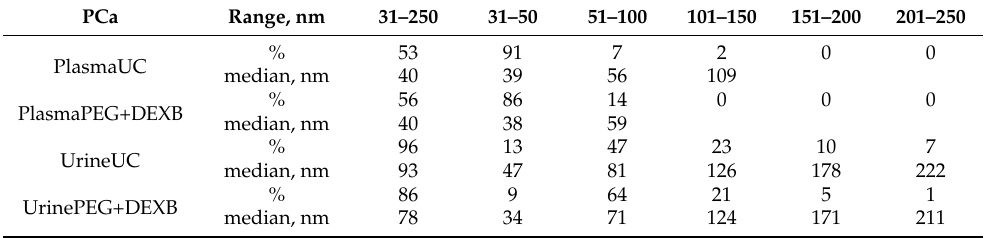
Table 2. The TEM data on EVs size in samples from healthy donors (HD). Percentage and median size is presented. The percentage of EVs (from 31 to 250 nm) was counted from total number of particles in the sample (0–250 nm). The percentage of EVs fractions (from 31 to 50 nm, from 51 to 100 nm, from 101 to 150 nm, from 151 to 200 nm, from 201 to 250 nm) were counted from number of EVs ranged from 30 to 250 nm (considered as 100%).